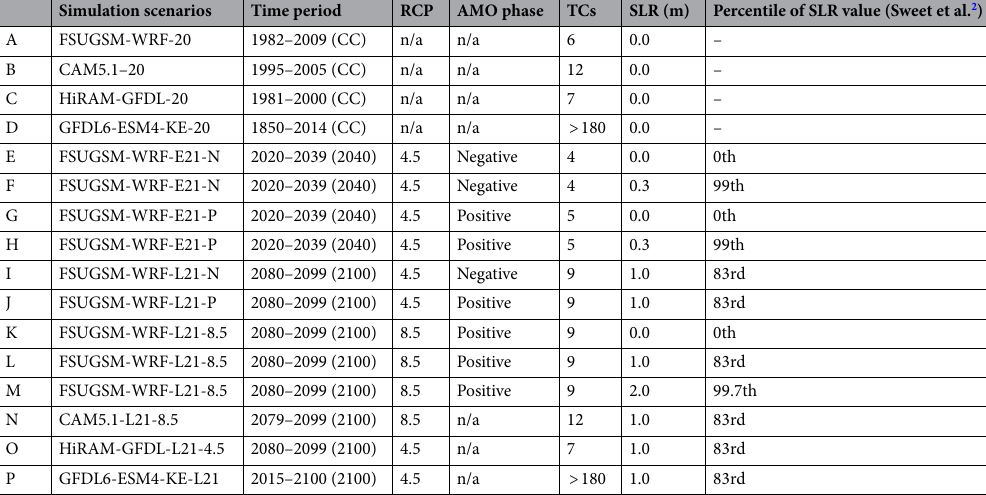
Figure SI-1a and SI-1b show ∆Cp values for landfalling TCs in FL and SWFL predicted by the above-mentioned climate and downscaling models as well as from histori- cal data. ∆Cp values predicted by various climate and downscaling models for FL (Fig. SI-1a) and SWFL (Fig. SI- 1b) generally increase from the late twentieth century to the late twenty-first century, except those obtained